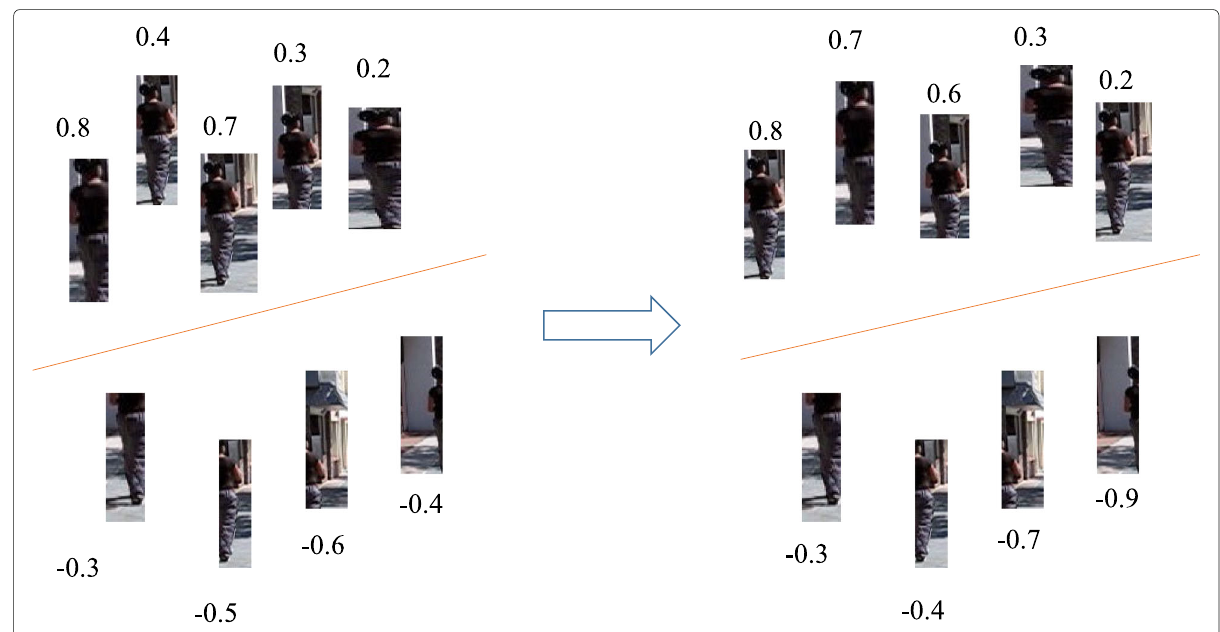
Fig. 1 Most of existing tracking methods only require to tell positive samples from negative ones as shown by the left panel. However, this is not enough for the visual tracking task as it needs to filter out the one having the largest IoU with the ground truth. To overcome this problem, we propose to predict scores that are consistent with the ranking order in term of IoU with the ground truth as shown by the right